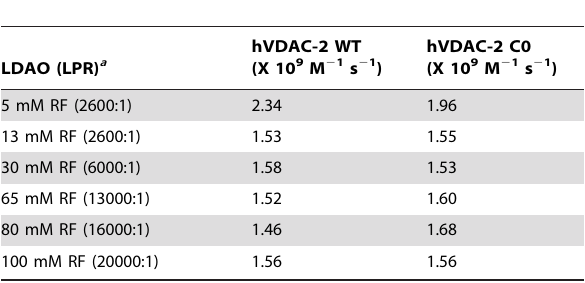
Table 3. Bimolecular quenching constants for refolded hVDAC-2 WT and C0 in various LDAO concentrations.